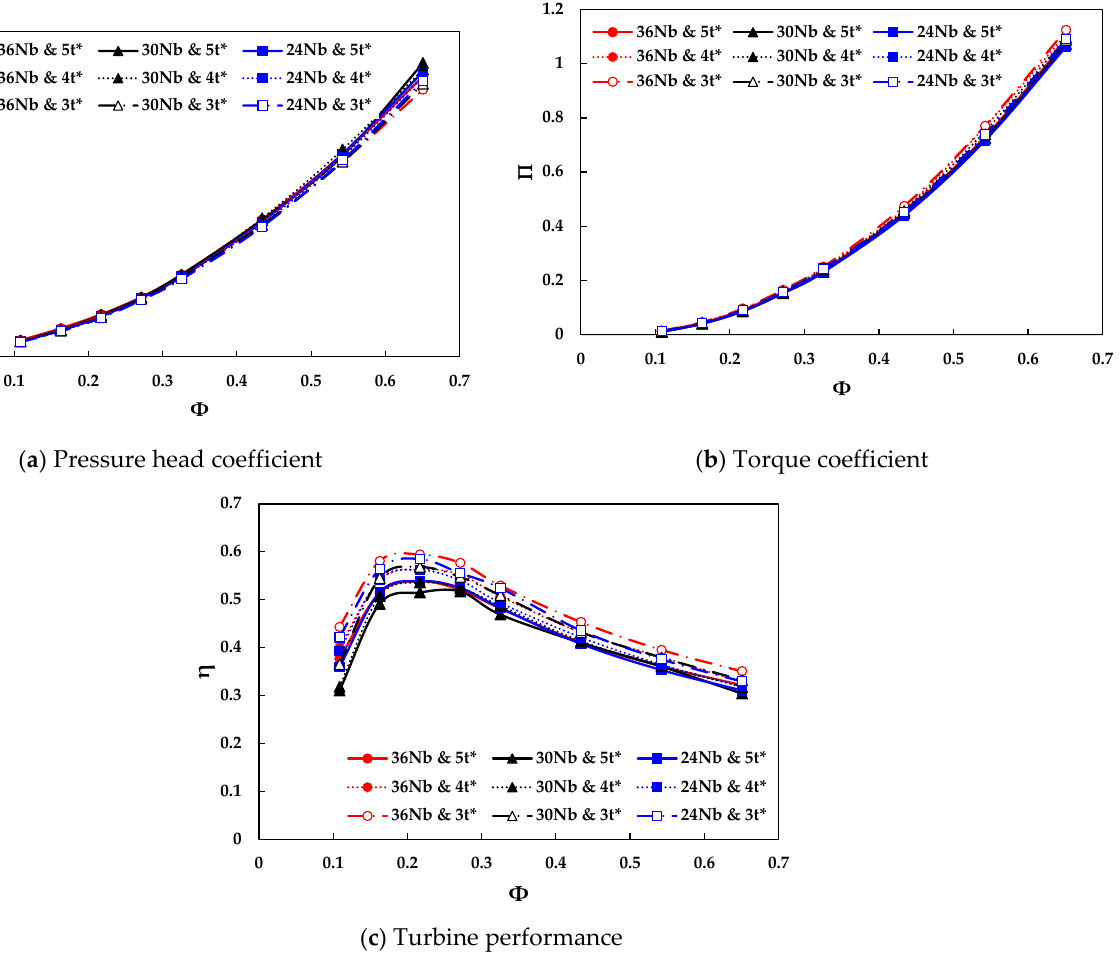
Figure 5. Effect of thickness and number of rotor blades on the turbine performance at 350 rpm constant rotational speed.